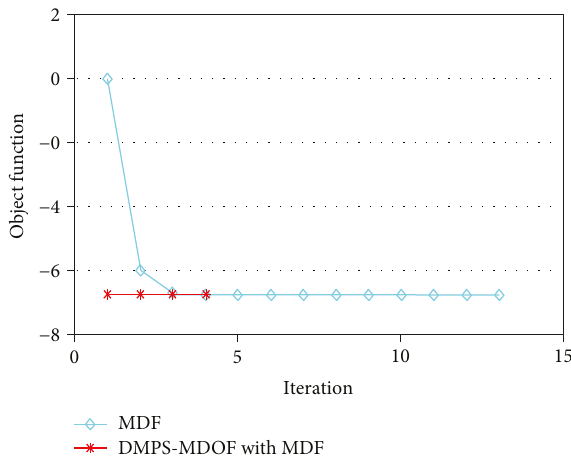
Figure 7: Iteration history on the objective